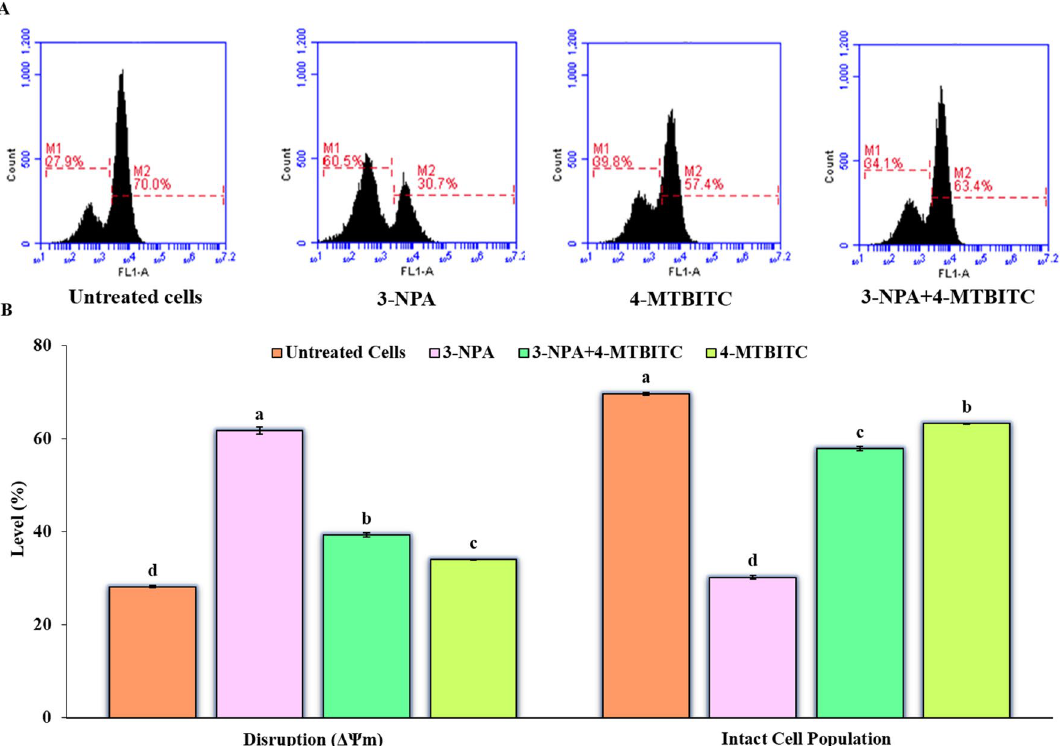
Figure 7. ( A ) Representative dot plots of flow cytometric loss of MMP for the 3-NPA exposed SH-SY5Y cells with or without 4-MTBITC in contrast to control cells. M1 represents the proportion (%) of cells with disrupted potential (Δψ m ) in comparison to intact cells depicted as M2 phase ( B ) Quantification of the membrane potential and intact cell population. Values are represented as the mean ± SEM; n = 3 set of independent experiments. MMP, mitochondrial membrane